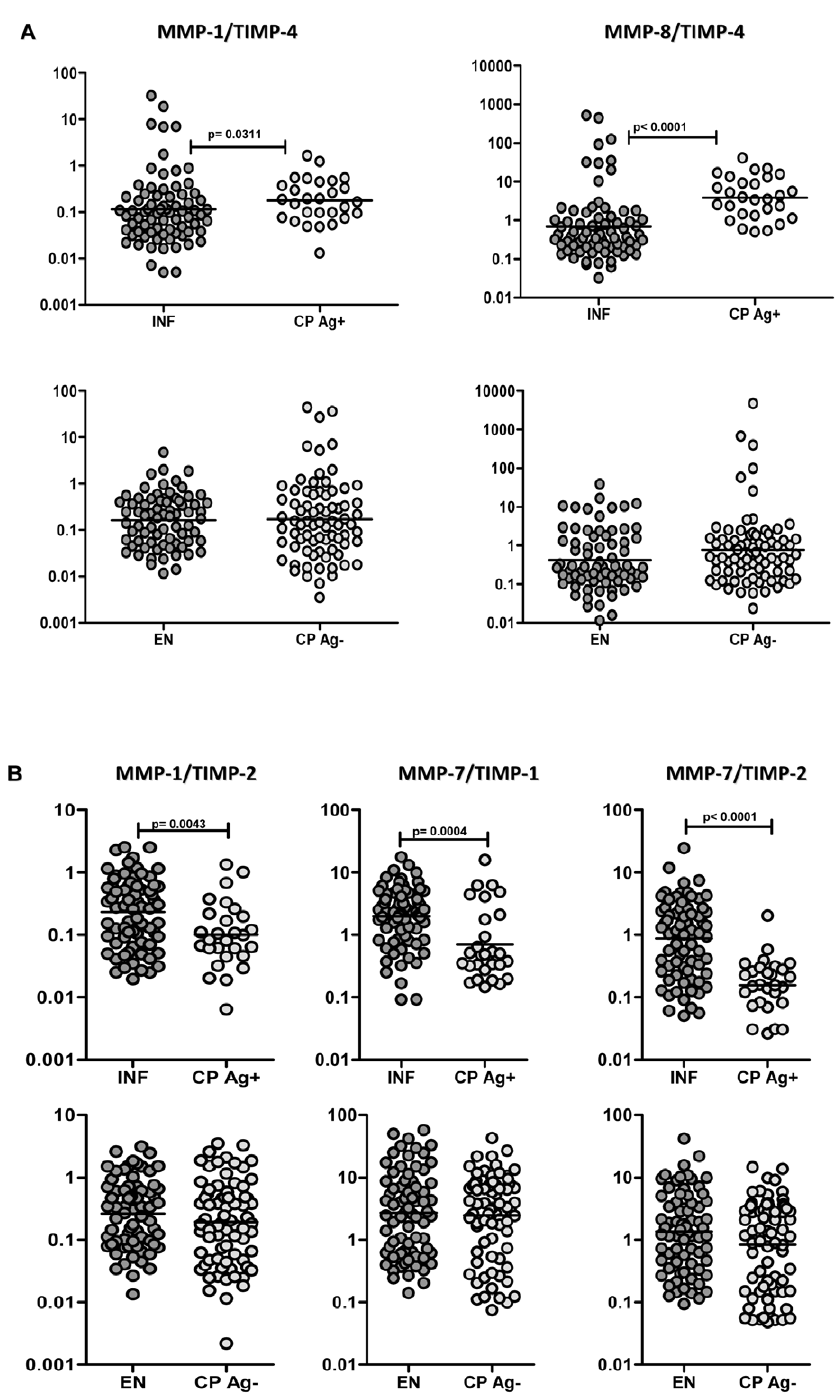
Figure 3. Altered MMP to TIMP ratios in filarial infection and lymphedema. (A) Ratio of circulating levels of MMP-1/TIMP-4 and MMP-8/ TIMP-4 from filarial lymphedema individuals with active infection [CP Ag + ] and asymptomatic infected [INF] individuals as well as from filarial lymphedema individuals without active infection [CP Ag 2 ] and endemic normal [EN] individuals are shown. (B) Ratio of circulating levels of MMP-1/ TIMP-2, MMP-7/TIMP-1, and MMP-7/TIMP-2 from filarial lymphedema individuals with active infection [CP Ag + ] and asymptomatic infected [INF] individuals as well as from filarial lymphedema individuals without active infection [CP Ag 2 ] and endemic normal [EN] individuals are shown. P values were calculated using the Mann-Whitney test.